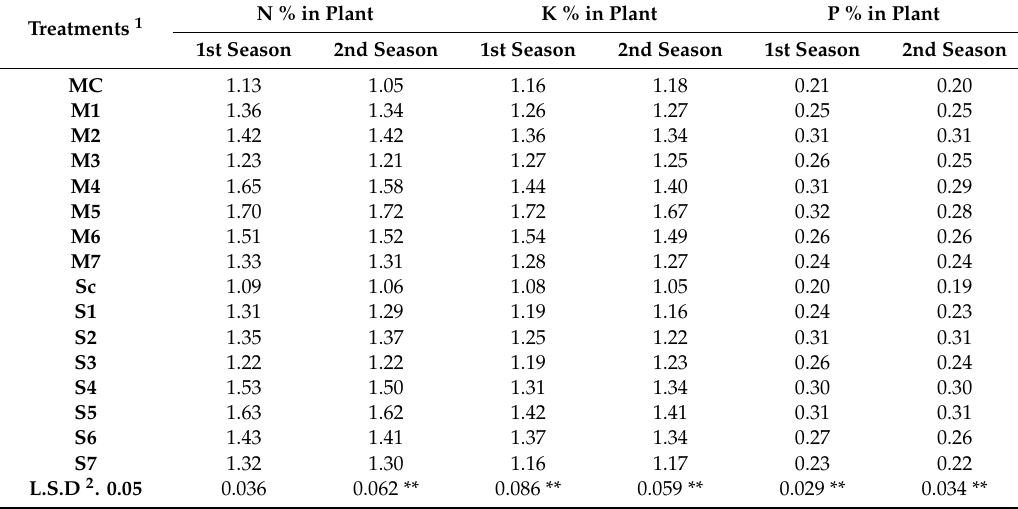
Table 3. E ff ect of spent mushroom substrate extract (SMSE), mushroom culture filtrate (MCF), and Roundup treatments to control broomrape infestation, on percent (%) content of nitrogen (N), potassium (K) and phosphorous (P) in faba bean plants at 60 days from sowing, during two seasons. Treatments 1